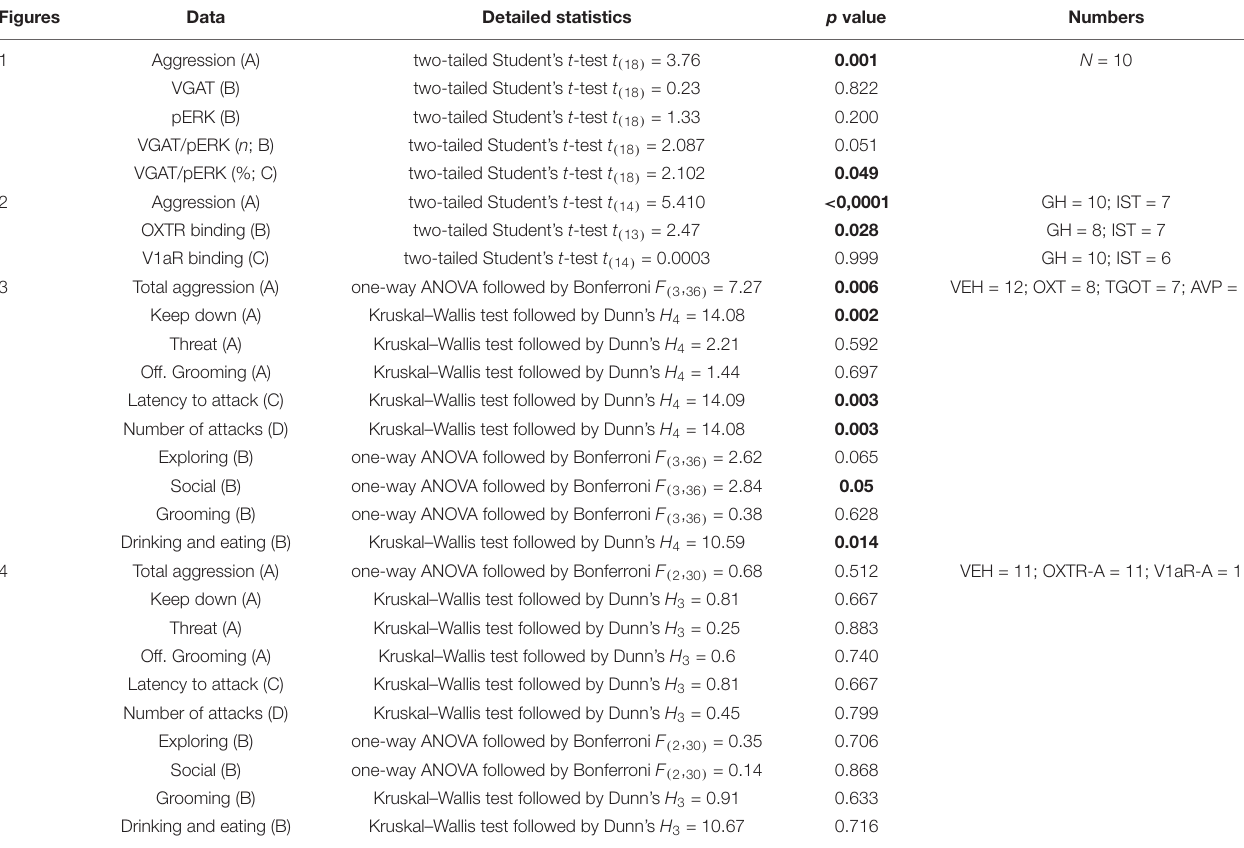
TABLE 1 | Overview of detailed statistical analysis as well as p values for all data displayed in Figures 1–4 .